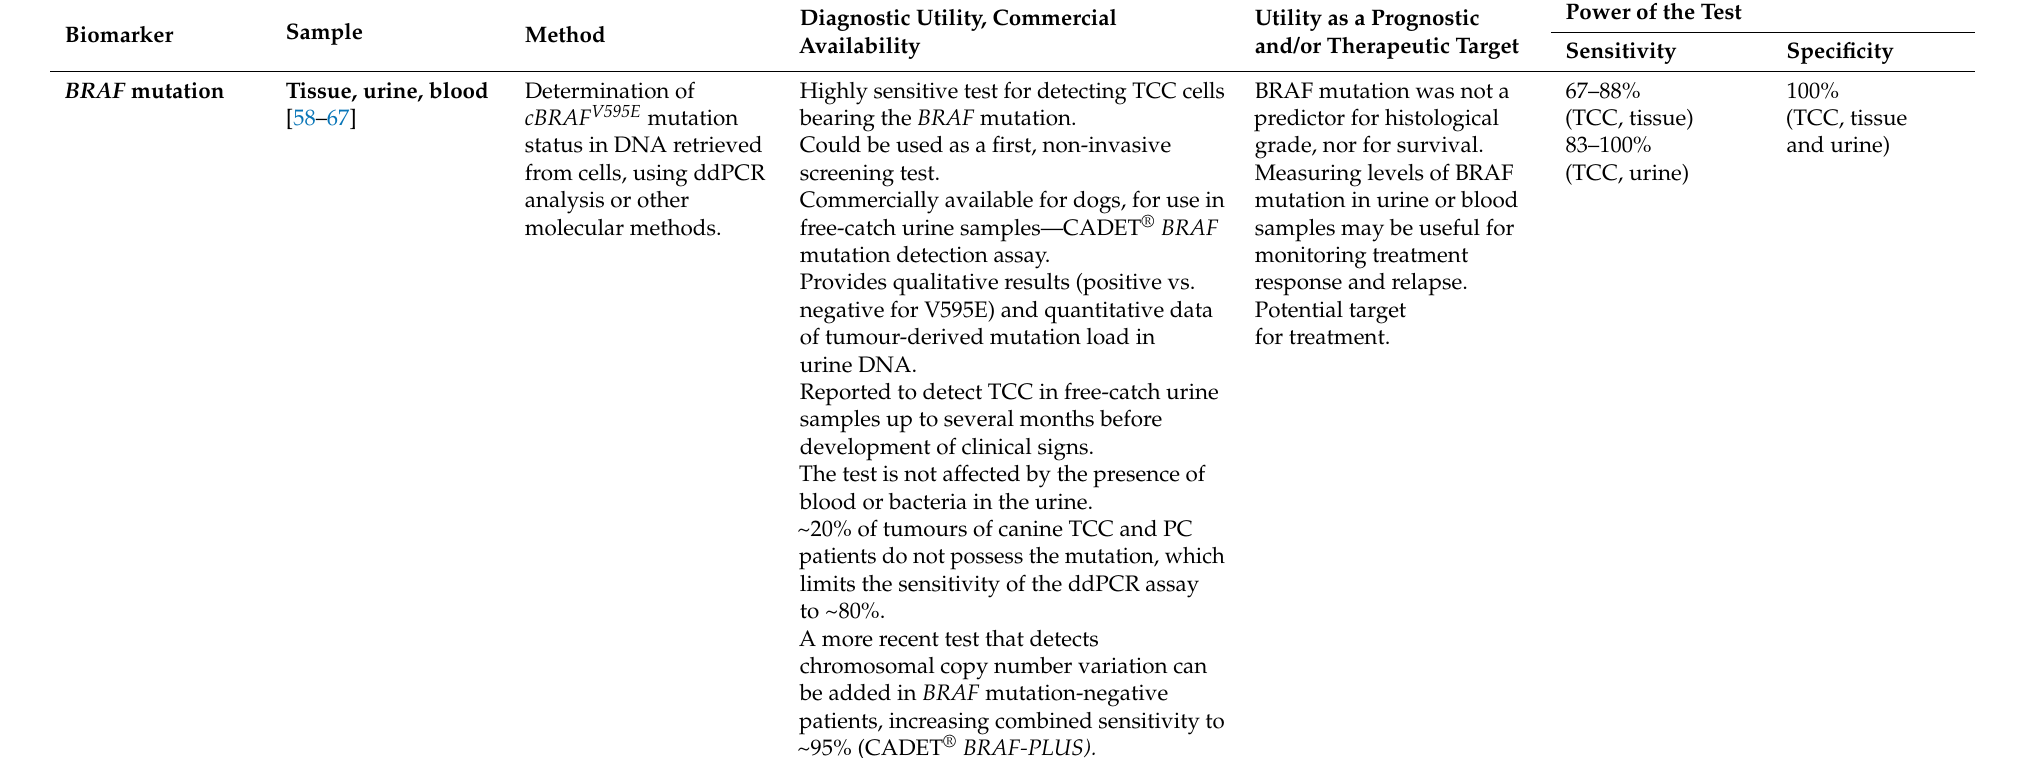
Table 3. Current and potential markers for clinical applications in canine transitional cell